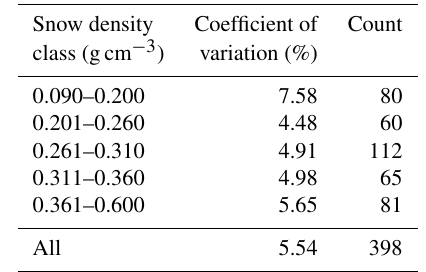
Table 1. Average coefficient of variation (CV) of three replicate measurements of snow density that were measured with a wedge density cutter for different snow density classes.